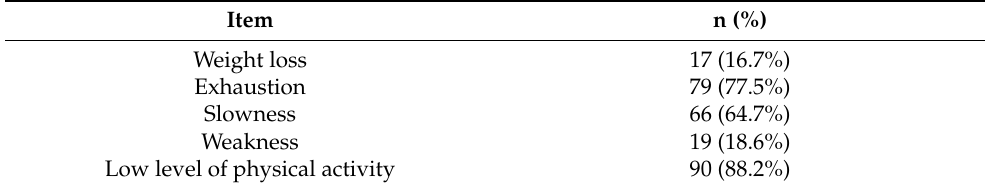
Table 4. Fried scale per item.